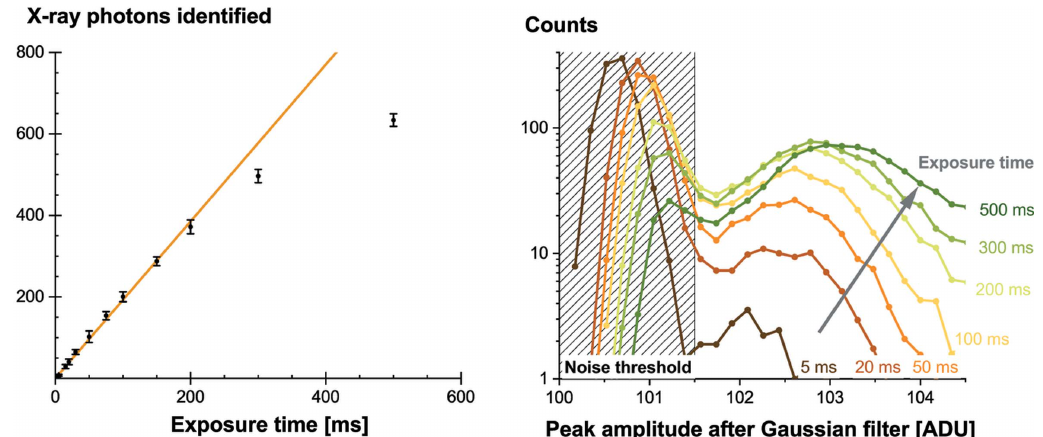
Figure 14 Linearity of the number of identified photons as a function of the exposure time (left) and influence on the identified peak amplitude (right). The X-ray energy is 40 keV, the scintillator is an 11 m m GOS:Tb powder screen and the pixel size is 6.5 m m.